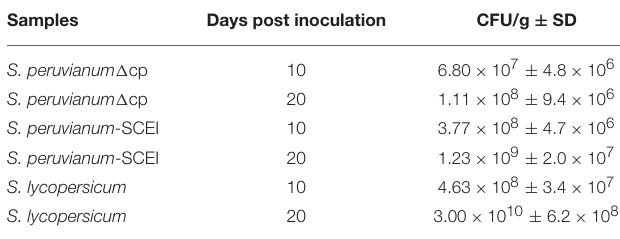
TABLE 1 | Cmm populations estimated by qRT-PCR of the constitutive Cmm TomA gene in inoculated stems of S. peruvianum inoculated with ToMoV 1 CP or ToMoV_ SCE I or S. lycopersicum cv.